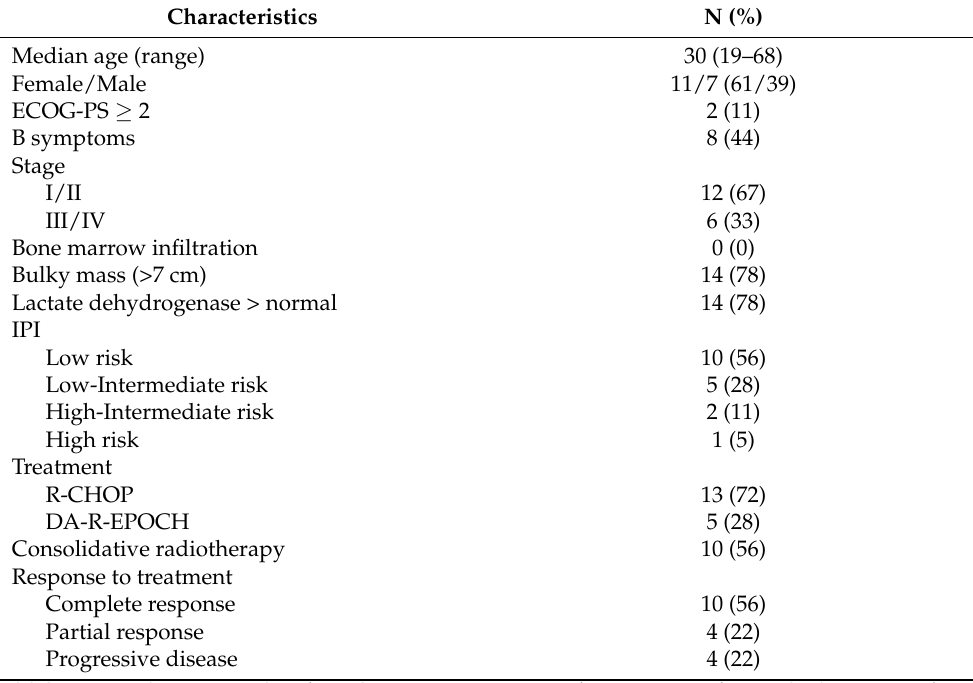
Table 1. Main baseline features, treatment, and response of the 18 patients with